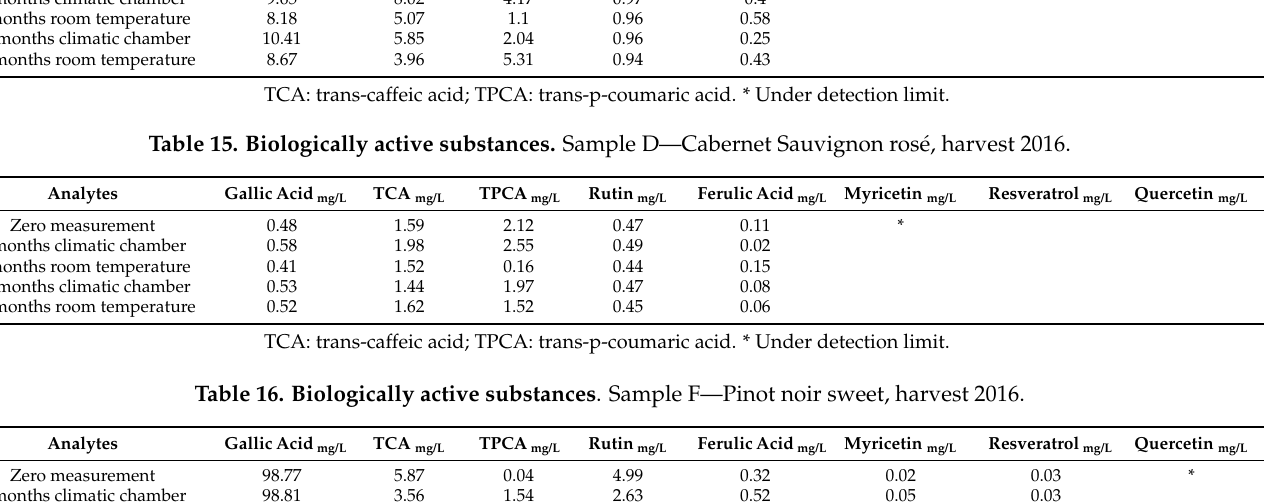
Table 14. Biologically active substances . Sample C—P á lava, harvest 2016. Analytes GallicAcid mg/L Zero measurement